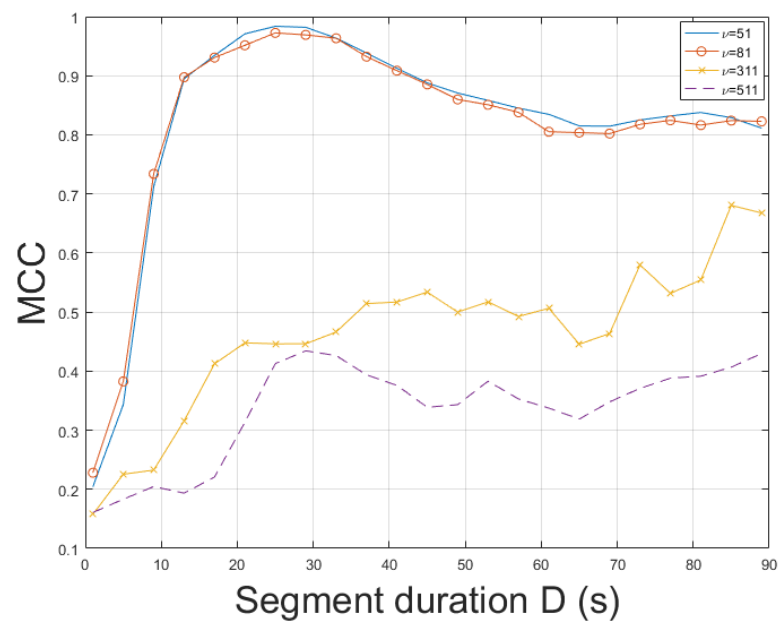
Figure 9. Maximum correlation coefficient of the proposed approach employing SLIC+STFT for various bandpass filter orders and segment durations (mov4).